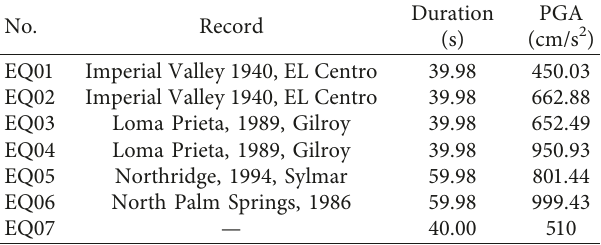
Figure 17: Dynamic responses of the FSCW structure under seismic excitations. (a) Time-history curve of the rotation angle of the wall; hysteresis curve of (b) the left damper, (c) the right damper, and (d) the frame. Table 1: Earthquake records involved in this study.